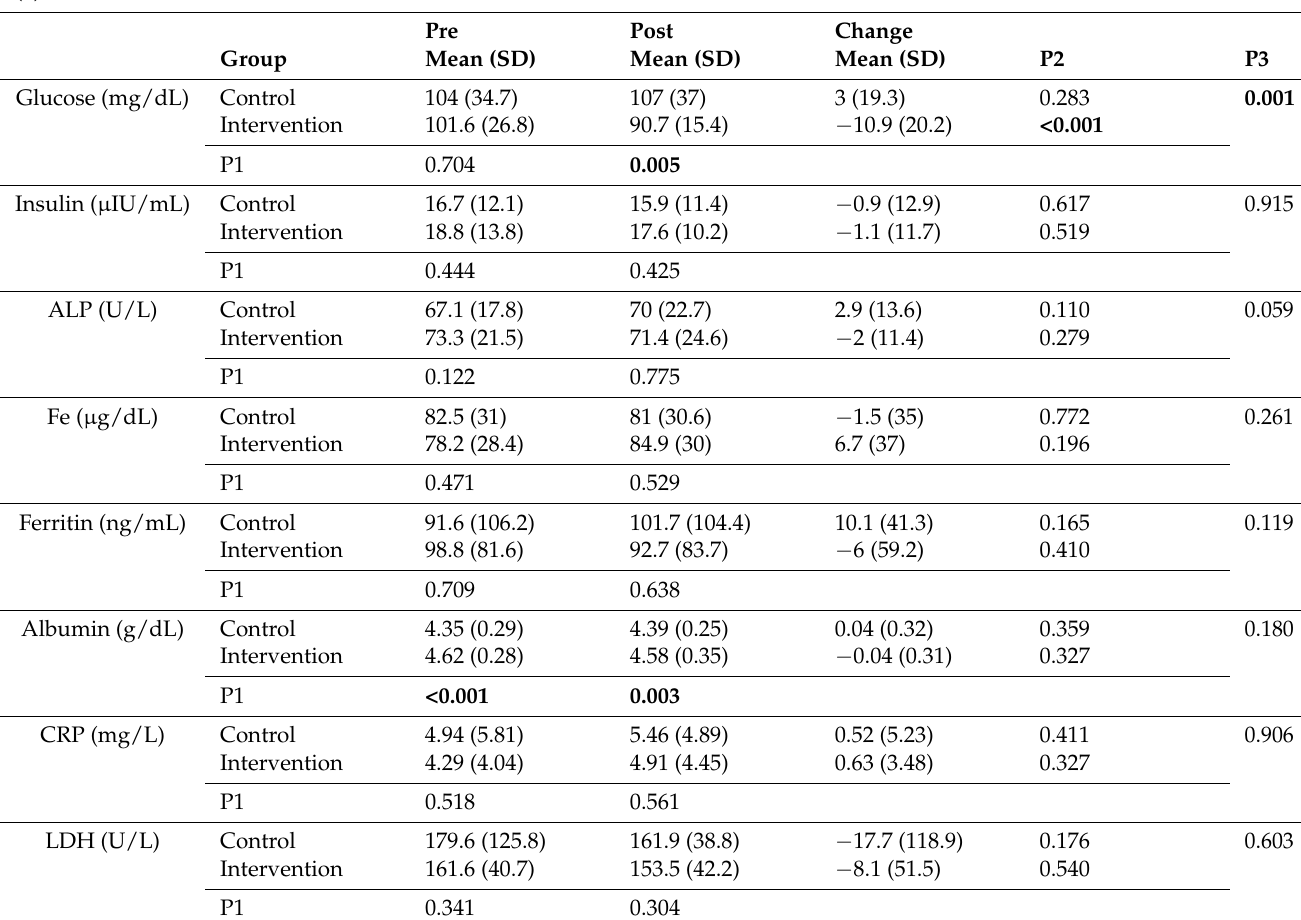
Table 3. (a): Changes in biochemical measurements after 3 months in control vs. the intervention group; (b): Changes in lipid profile, hepatic enzymes and markers of renal function after 3 months in control vs. the intervention